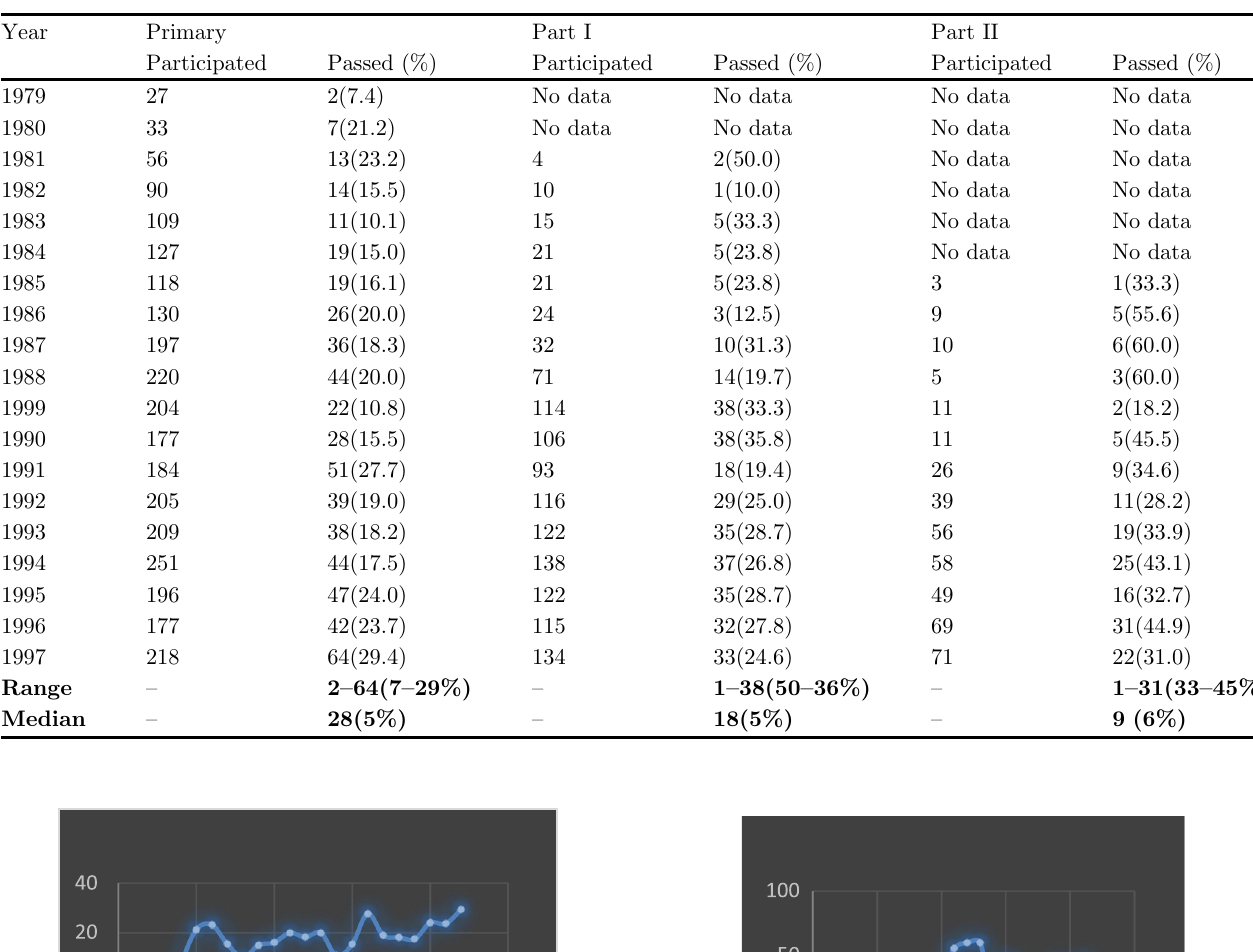
Table 1. Pass rate of the WACS examination from 1979 to 1997.